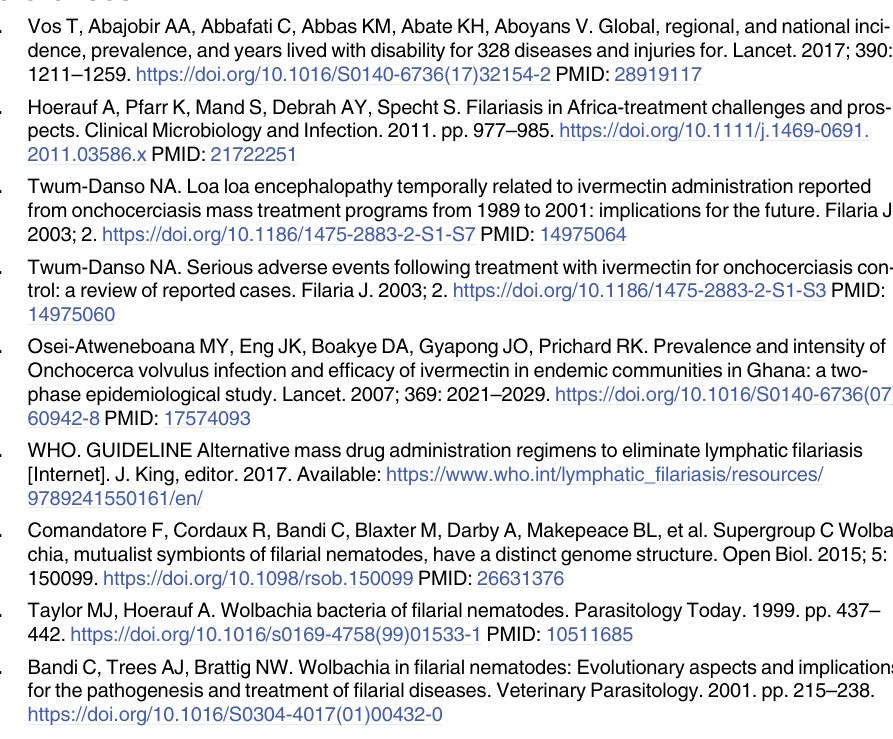
S3 Fig. The activity of LDH in protein extracts prepared from filarial nematodes ( B . malayi , Bm or A . viteae , Av) and in human-LDH (Hu-LDH) is inhibited by SO.